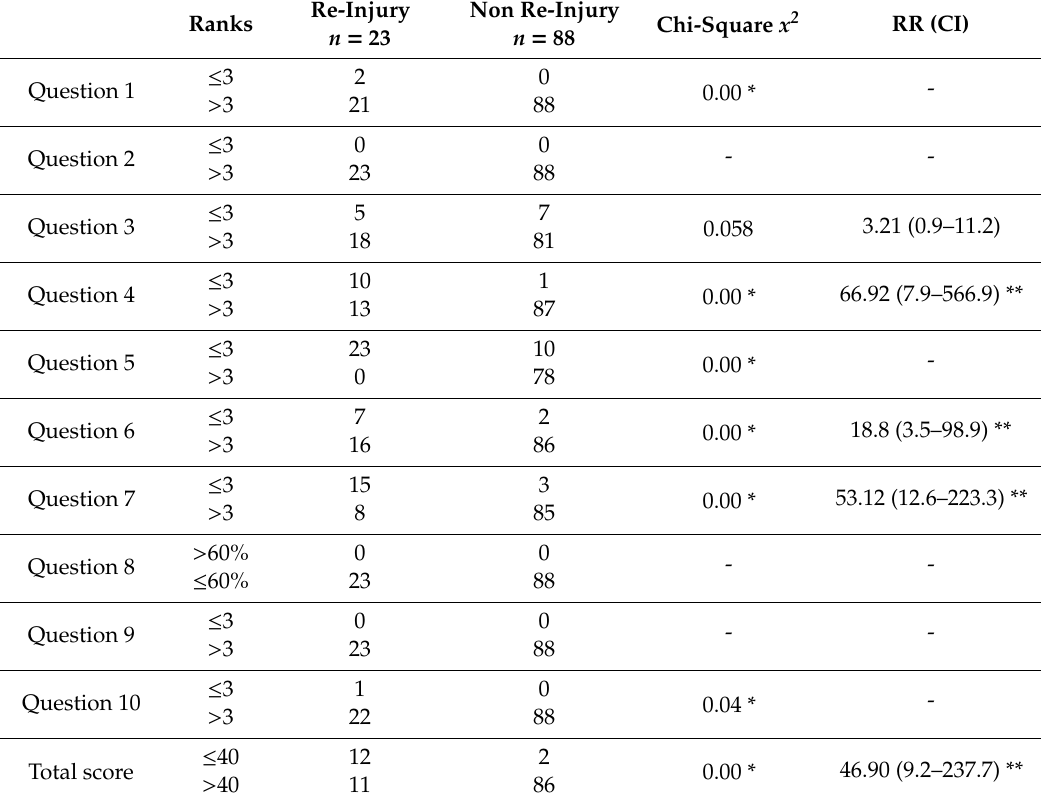
Table 5. Association between score and re-injury.